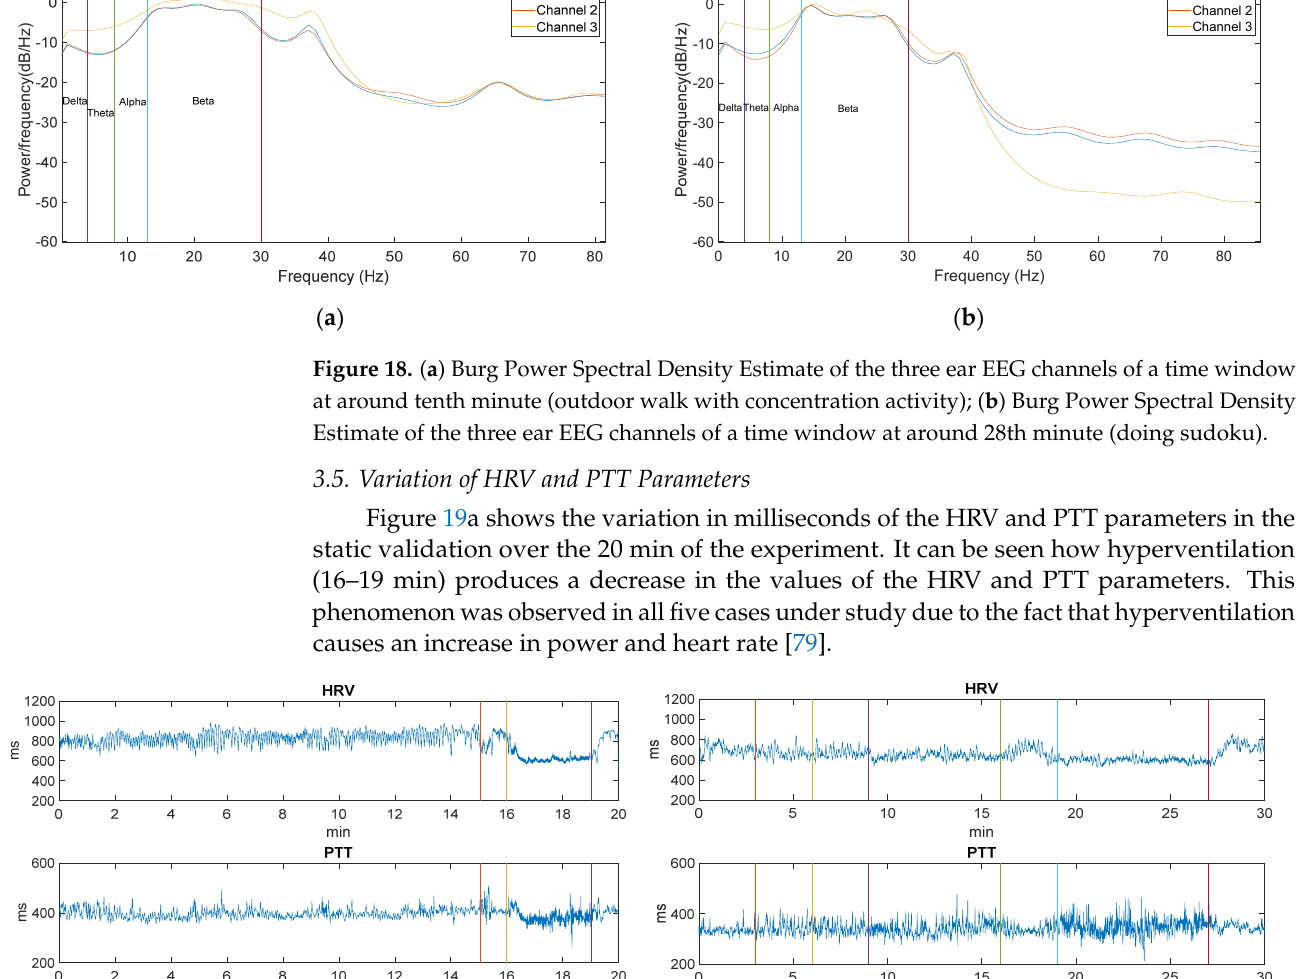
Figure 18. ( a ) Burg Power Spectral Density Estimate of the three ear EEG channels of a time window at around tenth minute (outdoor walk with concentration activity); ( b ) Burg Power Spectral Density Estimate of the three ear EEG channels of a time window at around 28th minute (doing sudoku).